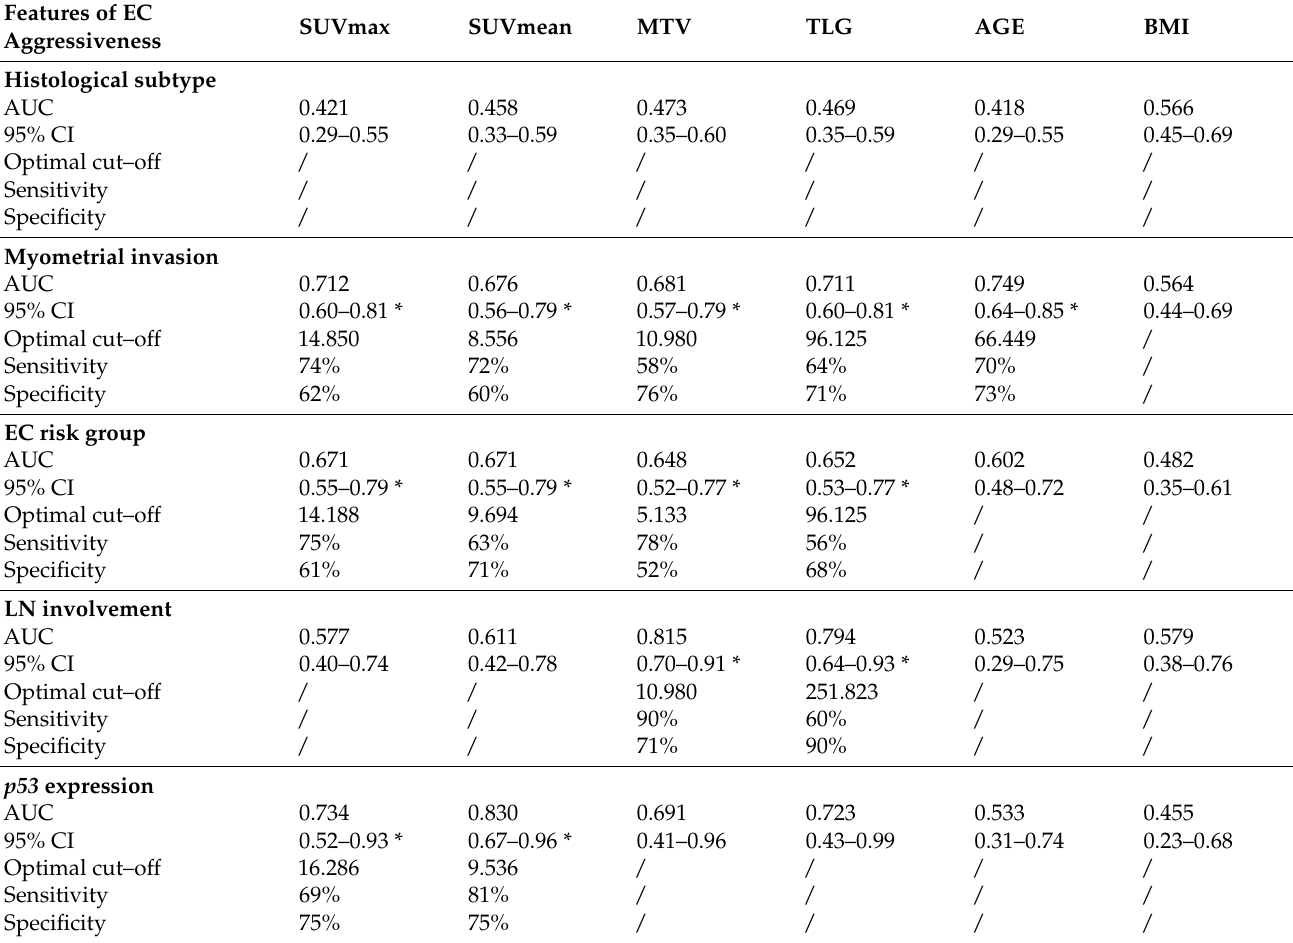
Table 3. Predictive value of 18 F-FDG PET and clinical parameters with respect to features of EC aggressiveness on the training